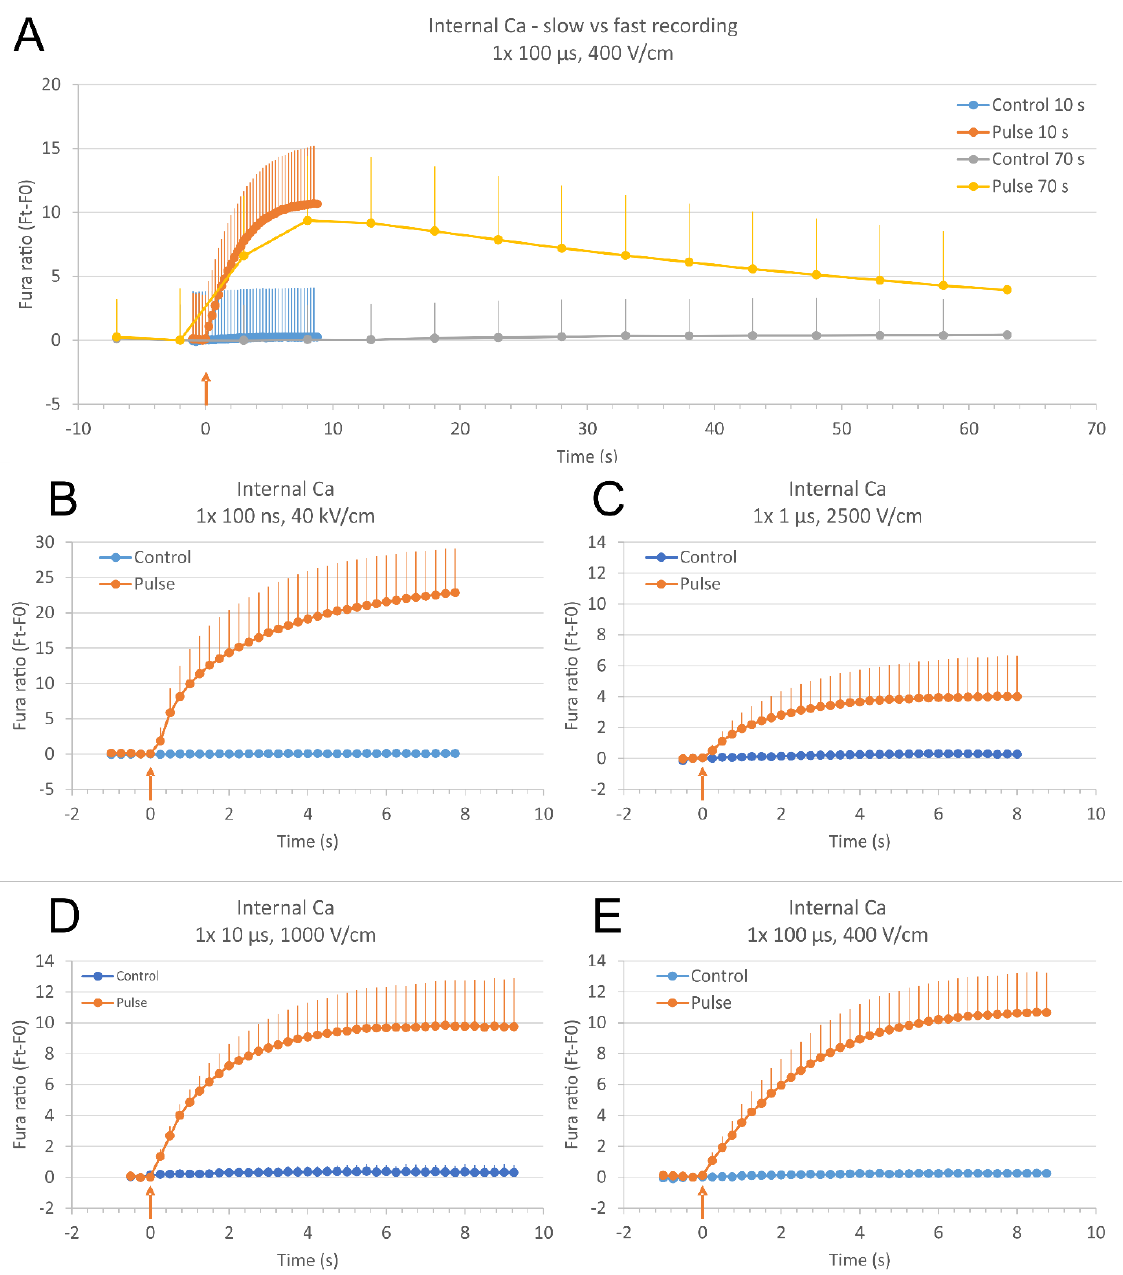
Figure 1. Relative calcium ion (Ca 2+ ) concentration in cells after electroporation with single pulses of different duration as monitored with a fluorescent calcium indicator Fura-2 and expressed in Fura-2 ratio 340/380 over time (subtracted baseline). A higher Ca 2+ concentration results in a higher Fura-2 ratio 340/380. ( A ): Comparing fast- and slow-acquisition modes of calcium ions (Ca 2+ ) detection in electroporated cells exposed to a single 100 μs, 400 V/cm pulse. Fast-acquisition mode (10 s, solid lines): total duration of image acquisition: 10 s, time interval between images: 250 ms, number of recorded images: 41. Slow-acquisition mode (70 s, dashed lines): total duration of image acquisition: 70 s, time interval between images: 5 s, number of recorded images: 15. Slow-acquisition mode was done on the same cells 15 min after fast-acquisition, allowing the cells to reseal. Time of pulse application is adjusted to the same pulse delivery time (noted with a red arrow). Results are presented as mean from four experiments (15 – 19 cells per experiment analyzed). ( B – E ): Relative Ca 2+ concentration in cells after electroporation with a single 100 ns, 40 kV/cm ( B ), 1 μs, 2500 V/cm ( C ), 10 μs, 1000 V/cm ( D ), and 100 μs, 400 V/cm pulse ( E ) as expressed in Fura-2 ratio 340/380 over time. Image acquisition was done every 250 ms. Results are presented as mean from nine ( B ), six ( C ), five ( D ), and four ( E ) experiments (5 – 27 cells per experiment analyzed, all cells were taken into account). Vertical bars represent SD. Controls are experiments without pulse application.